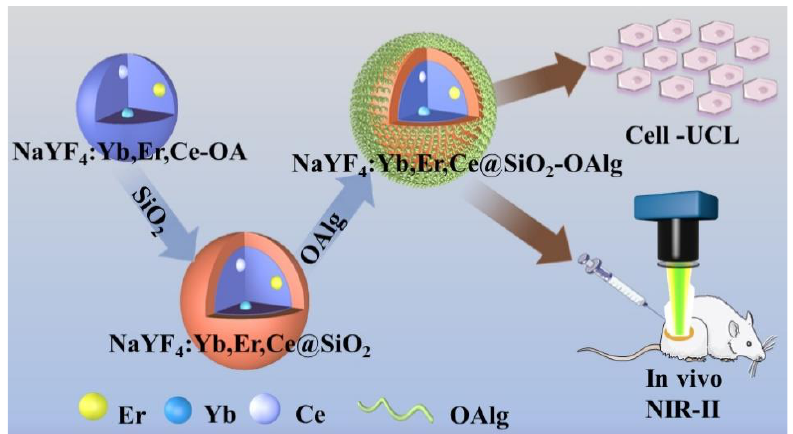
Figure 1. Scheme of the surface modification process of lanthanide luminescent nanoparticles by assisting with SiO 2 and OAlg molecules.